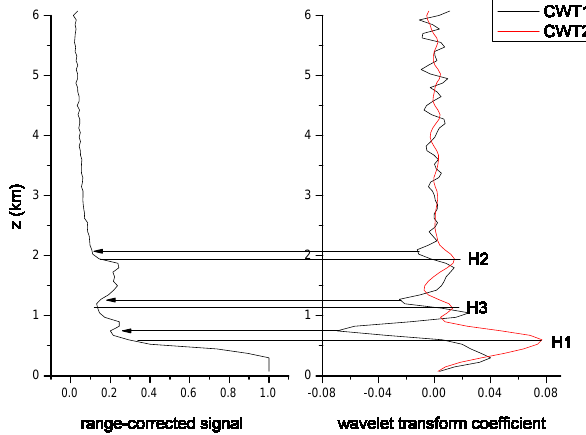
Fig. 1. Illustration for wavelet transformation, CWT 1 is used to de- tect the particle layer, and CWT 2 is used to follow the negative gra- dients of lidar profile. The minima of CWT 1 corresponding to the base and top of particle layer, are indicated by the arrows. The max- ima of CWT 2 correspond to the positions of negative gradients, and H 1 , H 2 , H 3 are the first three